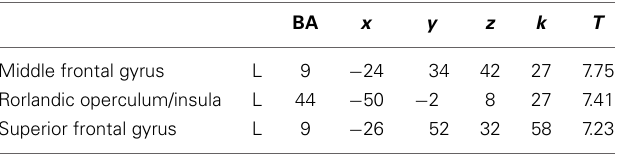
Table 3 | ASD > NT: group difference for happy vs. sad music (FWE p <